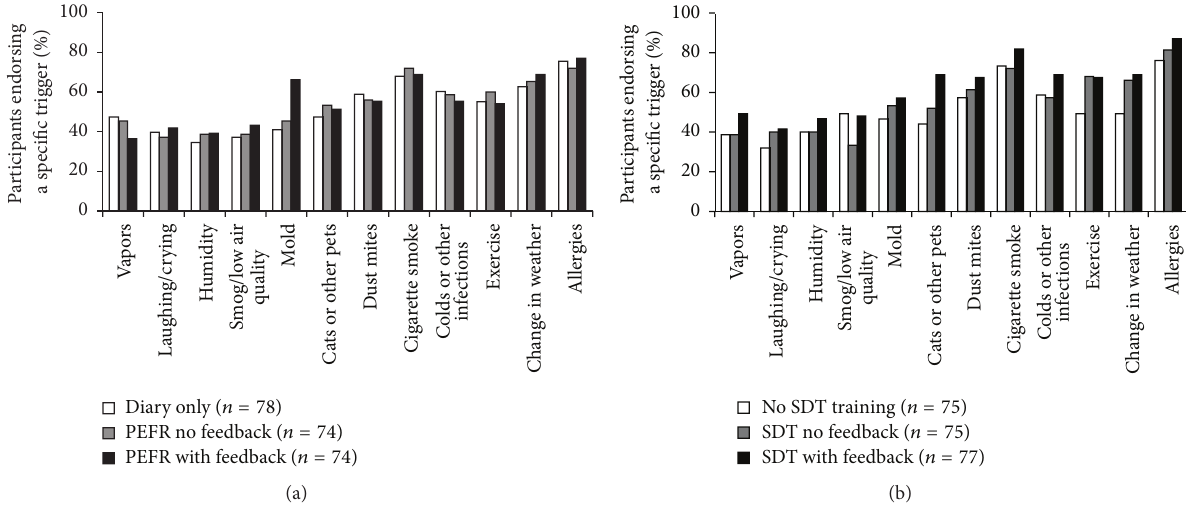
Figure 3: Triggers endorsed following home monitoring (a) and following resistive load signal detection training (SDT) (b).